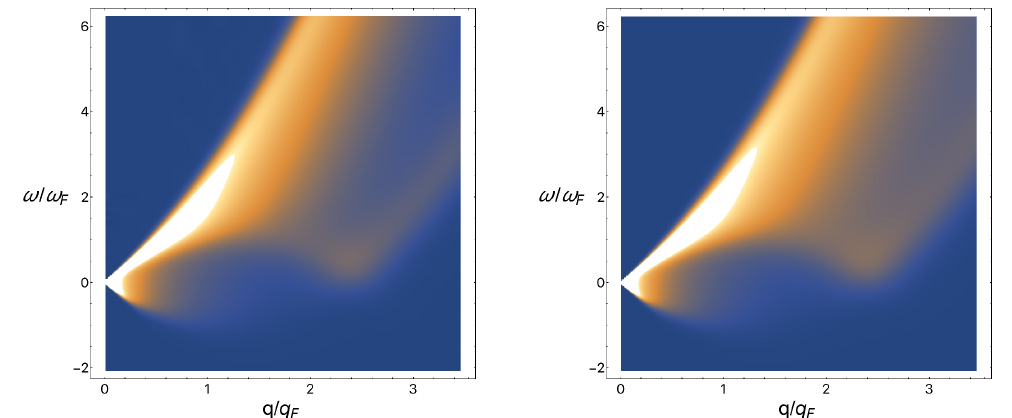
Figure 4: S ( q , ω ) (left panel) and S ( 1 ) ( q , ω ) (right panel) as functions of q and ω for a thermal state with β = 5, D = 0.396 and c = 4. The color scale is the same for both